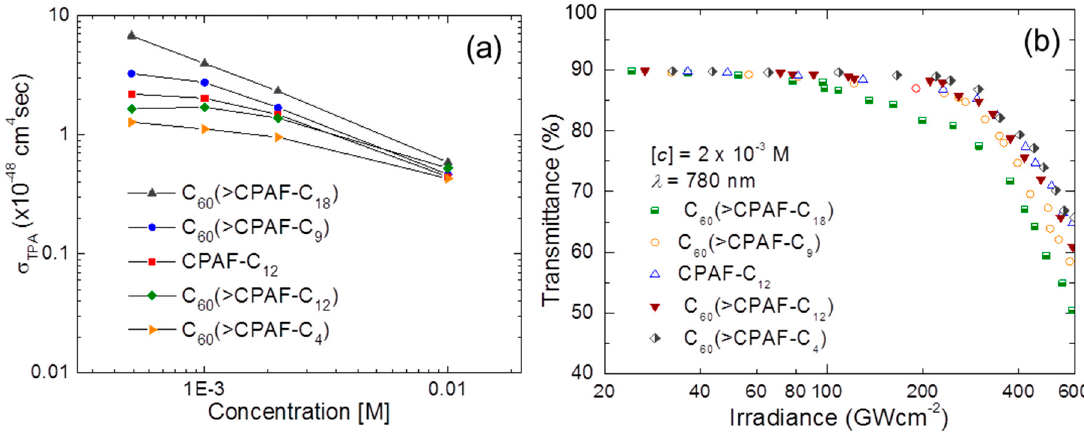
Figure 7. ( a ) Two-photon absorption cross-sections and ( b ) nonlinear absorption of 5 , 1 -C 4 , 1 -C 9 , 1 -C 12 , and 1 -C 18 in THF (2.0 × 10 − 3 M) measured as a function of irradiance with 226-fs laser pulses operated at 780 nm.